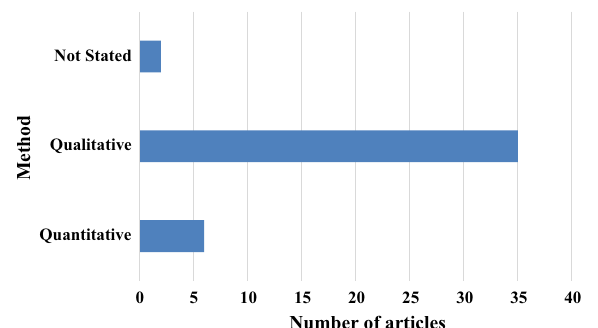
Fig. 2 Research methods used in the reviewed